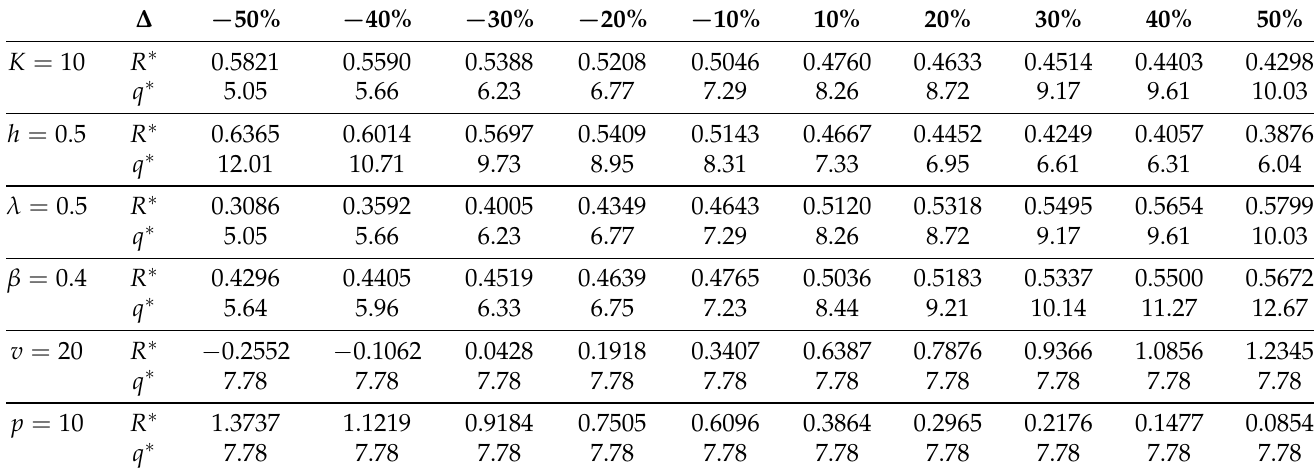
Figure 1. Return on investment (ROI) and inventory cost curves. Table 4. Optimal ROI solution of the model with different values of the initial